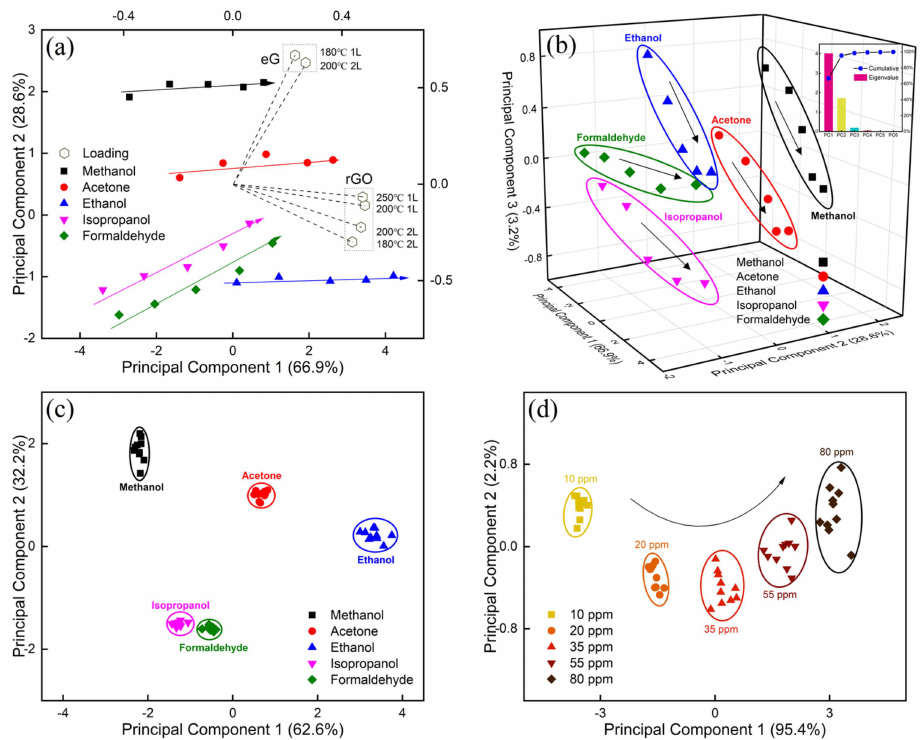
Figure 8. PCA results of the sensor array (two eG and four rGO sensors, as described in Table 1). ( a ) Score and loading plots toward target VOCs at different concentrations considering PC1 and PC2 (the upper and right axes indicate the loading results); ( b ) score plot toward target VOCs at different concentrations considering PC1, PC2 and PC3, inset shows the eigenvalues and cumulative contribution rate of each principal component in the scree plot; ( c ) qualitative recognition: score plot toward target VOCs at 20 ppm; and ( d ) quantitative recognition: score plot toward different isopropanol